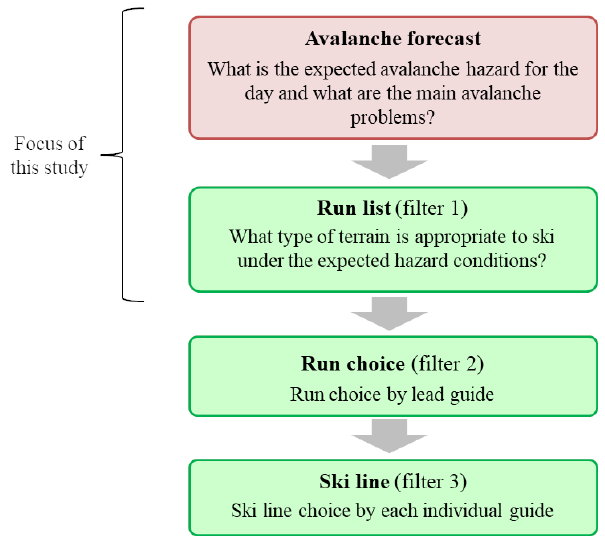
Figure 1. Hierarchical terrain selection process in mechanized ski- ing in